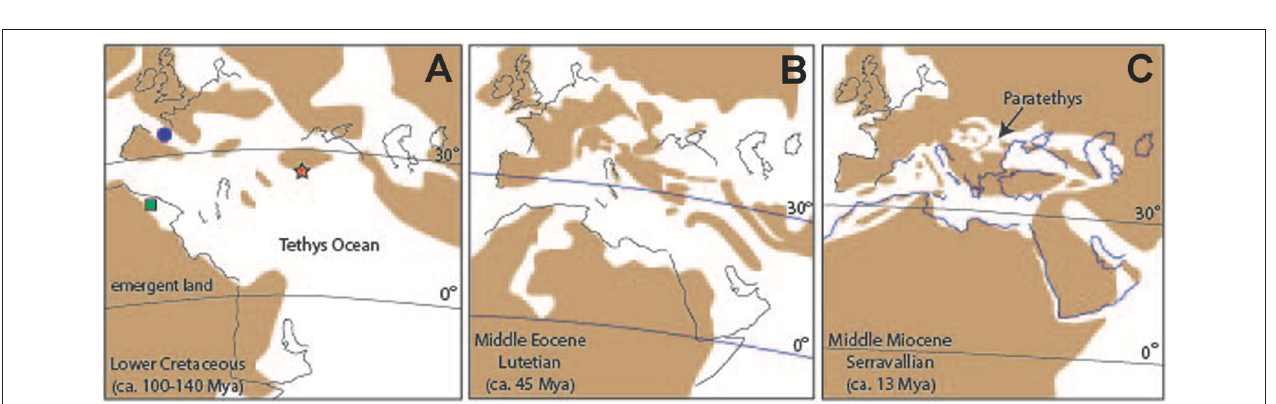
FIGURE 4 | Summary of the literature for Mediterranean corallines based on a critical bibliographic review and subdivided in research fields. (A) Overall information. (B) Information for the period 1990-present. The list of references used for the preparation of the figure (and details about the criteria used for the compilation of the list) is presented in the File SM1 .